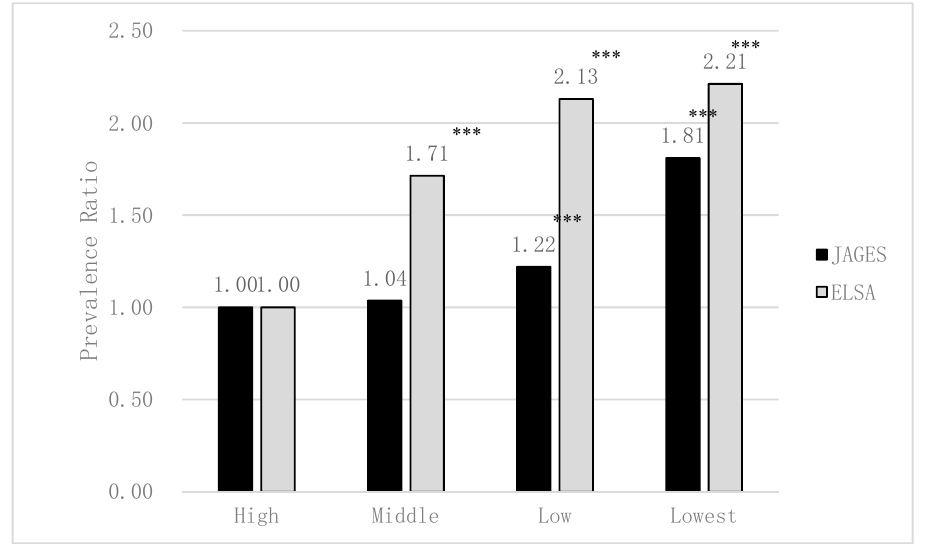
Figure 2. The association between edentulism and equivalised annual income in Japan and England estimated by Poisson regression analyses (adjusted for sex and age; JAGES N = 79,707, ELSA N = 5115). *** p < 0.001.